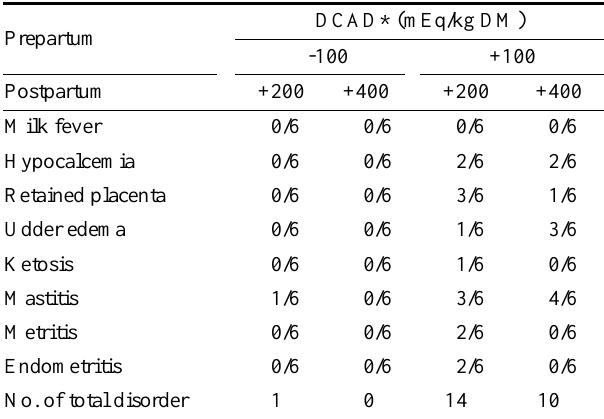
Table 8. The effect of dietary cation-anion difference on